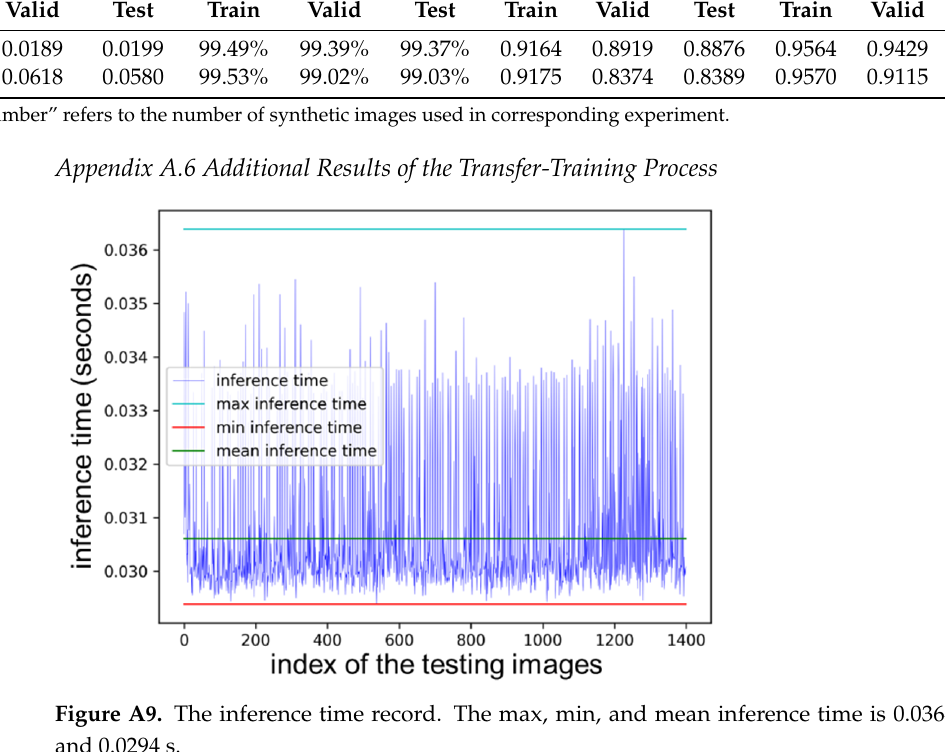
Table A3. The quantitative results of NI-U-Net++ tested using a different number of synthetic images.